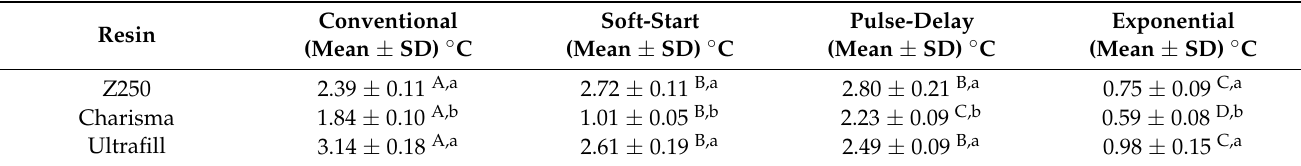
Figure 4. Temperature variation as a function of time on the tooth/resin set for the composites: ( A ) Z-250; ( B ) Charisma and ( C ) Ultrafill. Table 4. Mean and standard deviation of 30 maximum values of temperature variation. Different letters indicate statistically significant differences ( p -value < 0.05). Uppercase letters compare the effect of each photoactivation protocol on the temperature variation (within lines), and lowercase letters compare the temperature variation for each resin composite (within